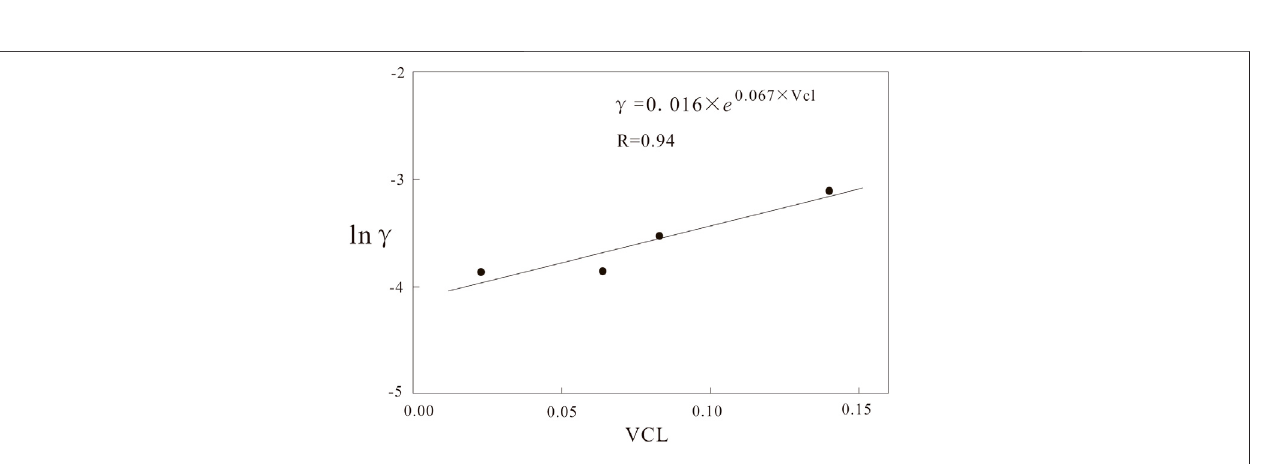
FIGURE 17 | Crossplot of the clay content and γ